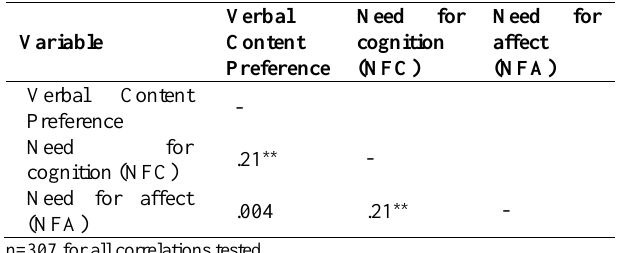
Table 3: Pearson correlation matrix among personality traits and verbal content preference